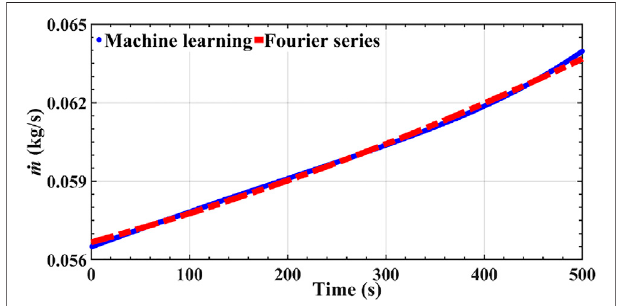
FIGURE7| Trigonometricfunction fi tsthetime-varyingcharacteristicsof the outlet